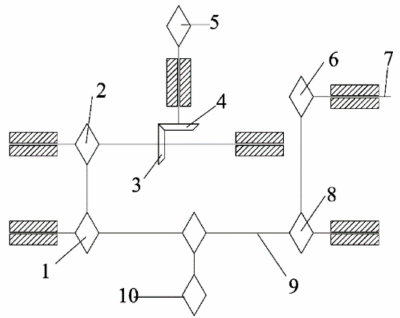
Figure 3. Drive system schematic: the sprocket 1 outputs power to the transplanting conveying device 2; the sprocket is linked with the main power shaft (3 and 4); 5 is the bevel gear; 6 is the power gear of the transplanting conveying device; 7 is the power gear of the crank; 8 is the power shaft linked with the crank; 9 represents the sprocket outputting power to the transplanting manipulator; and 10 is the main power shaft of the ground